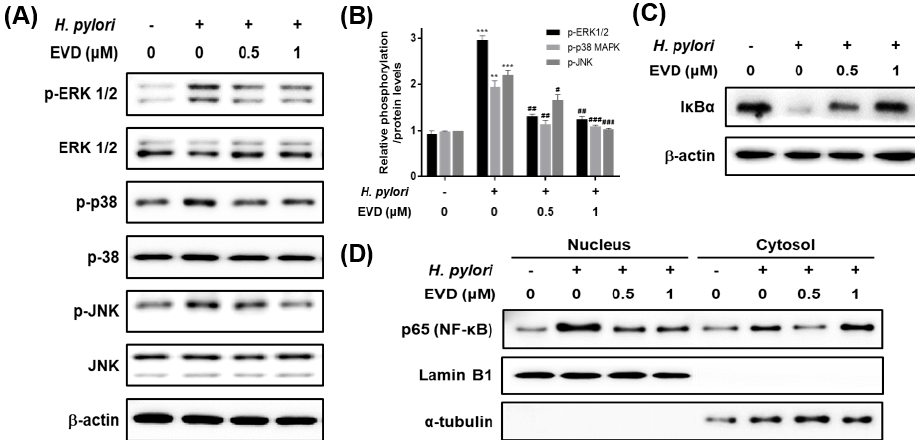
Figure 4. The inhibitory effects of evodiamine on H. pylori -induced activation of MAPK and NF- κ B and degradation of I κ B α in AGS cells infected with H. pylori . AGS cells were infected with H. pylori (200 MOI) and treated with indicated concentrations of evodiamine (0.5 and 1 μ M) for 12 h. ( A ) After incubation, cell lysates were collected and Western blot analysis of phosphorylated and total ERK 1/2, JNK and p38 was performed. β -actin was used as an internal control. ( B ) Each band intensity was normalized to β -actin. Data were presented as mean ± SEM. ** p < 0.01 and *** p < 0.001 vs. uninfected control. # p < 0.05, ## p < 0.01 and ### p < 0.001 vs. H. pylori -infected control without evodiamine treatment. ( C ) Western blot analysis of I κ B α was performed. β -actin was used as an internal control. ( D ) Cell lysates were separated into nuclear and cytosolic fractions, then performed to Western blot for NF- κ B. Lamin B1 was used as an internal control for nuclear fraction and α -tubulin was used as an internal control for cytosolic fraction. EVD, evodiamine.